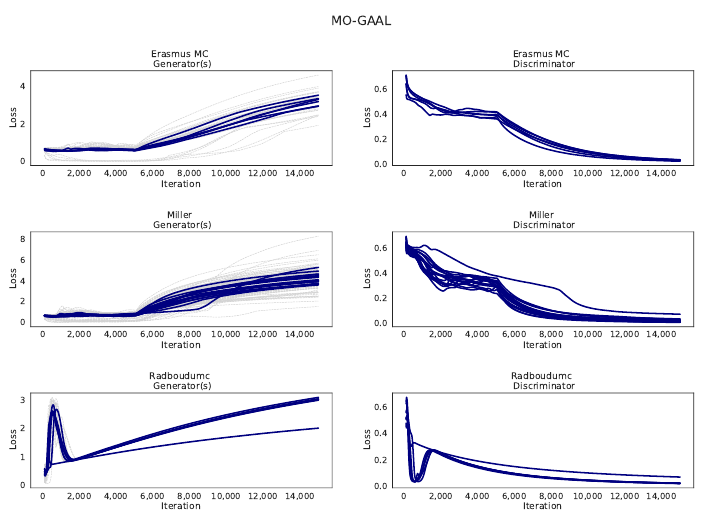
Figure A10. Learning curves for the MO-GAAL method with k = 5 (number of subgenerators). The generator and discriminator loss are displayed in each subplot. Note that each curve represent one cross-validation. The grey learning curves indicate the individual losses of the subgenerators.